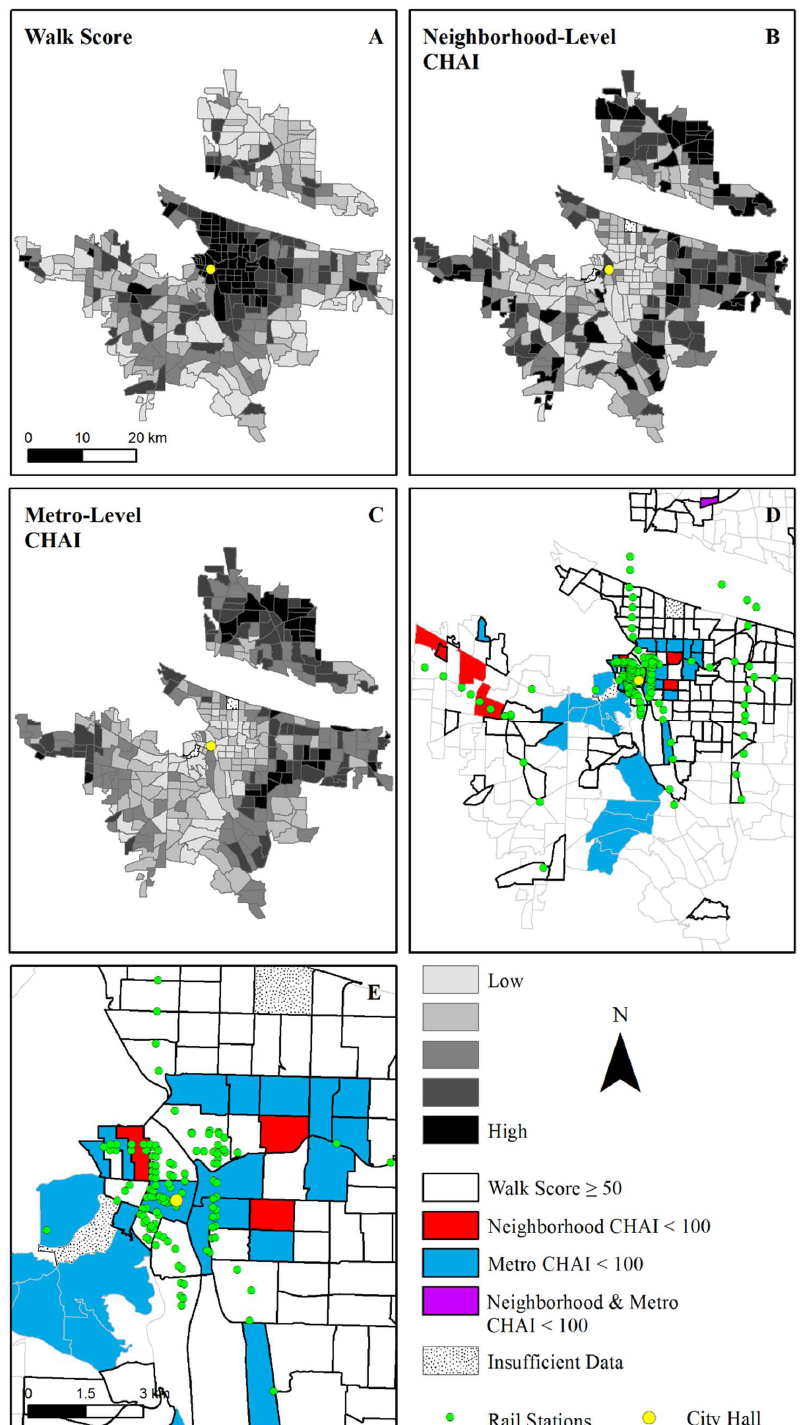
Figure 3. The spatial relationship between ( A ) walkability and housing affordability calculated at the ( B ) neighborhood and ( C ) metropolitan scale for census tracts within the urbanized area of Portland, OR. Of particular interest is where ( D ) relatively high walkability and low housing affordability overlap, most notably prominently around ( E ) the city center. The comprehensive housing affordability index (CHAI) was calculated by summing the standardized housing affordability for home owners and renters, and weighing each based on their proportion within each census